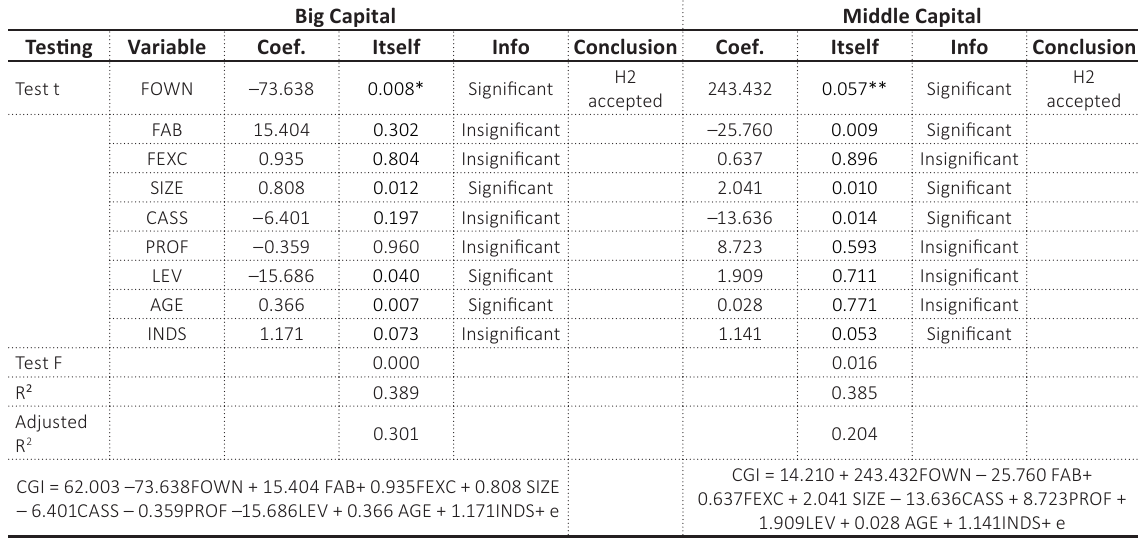
Table 6. Regression analysis results ( H2 ) Big Capital Middle